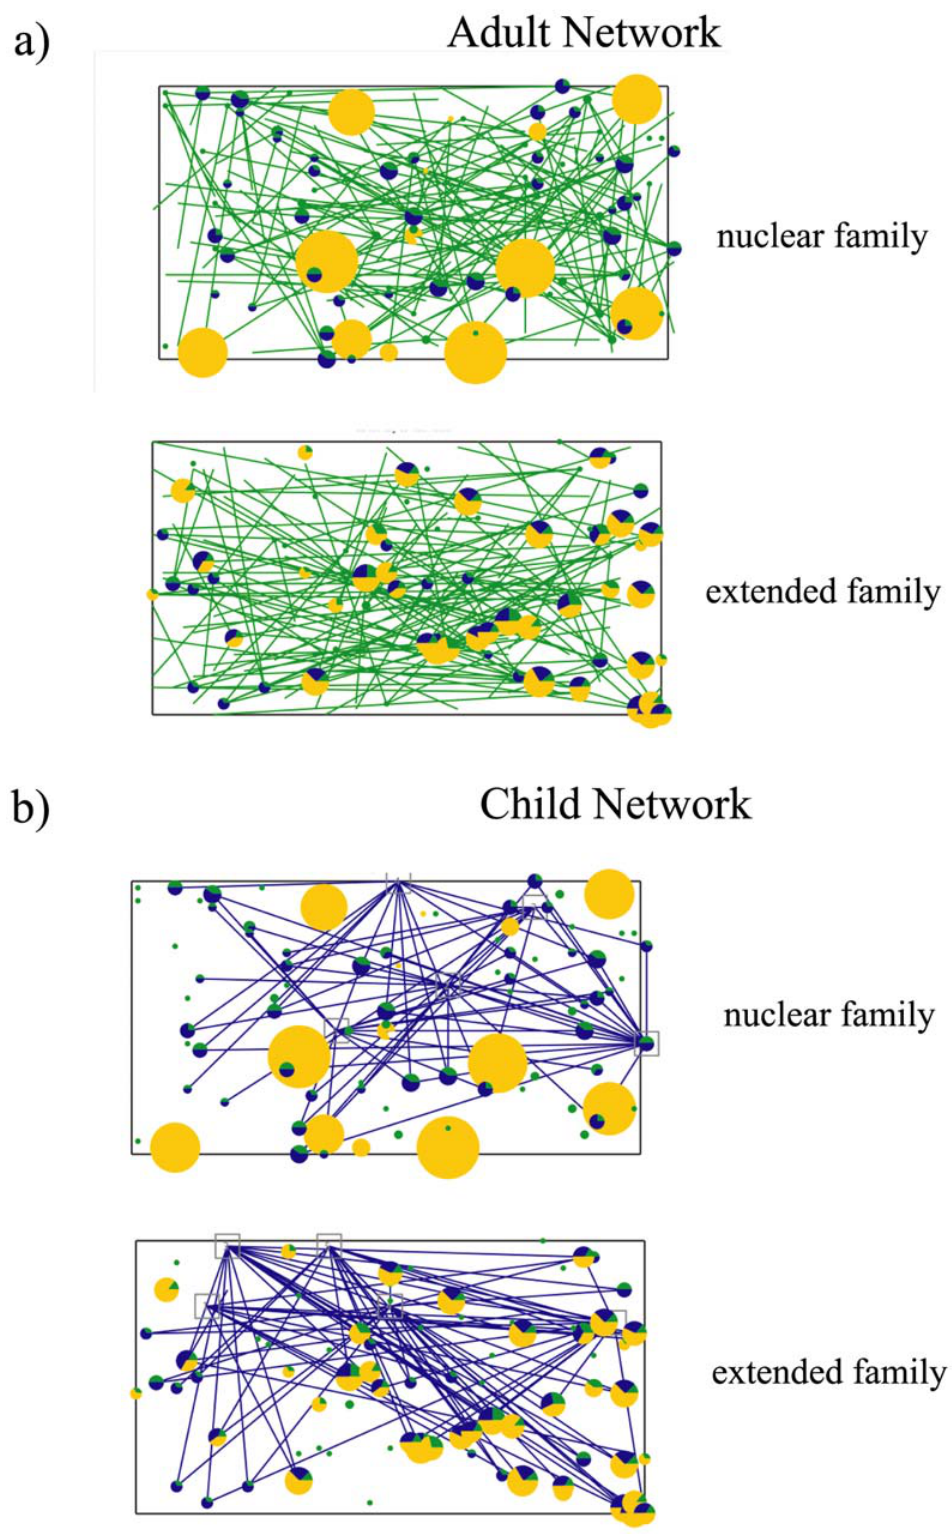
Figure 3. Example of an adult network (a: green lines) and a child network (b: blue lines) in an extended family culture and a nuclear family culture. The adult individuals are indicted by the green dots and their locations at various times of the day are indicated by the green lines that radiate from the initial location of the adult at home. Children are indicated by the blue dots, and the elderly by the yellow dots. The size of the dots indicates the number of people occupying the particular location. The child network includes the institutions (gray squares) where they attend public schools and the connectivity is indicated by the blue lines. The adult and child network connectivity is constructed by the same rules in both the nuclear family and the extended family.